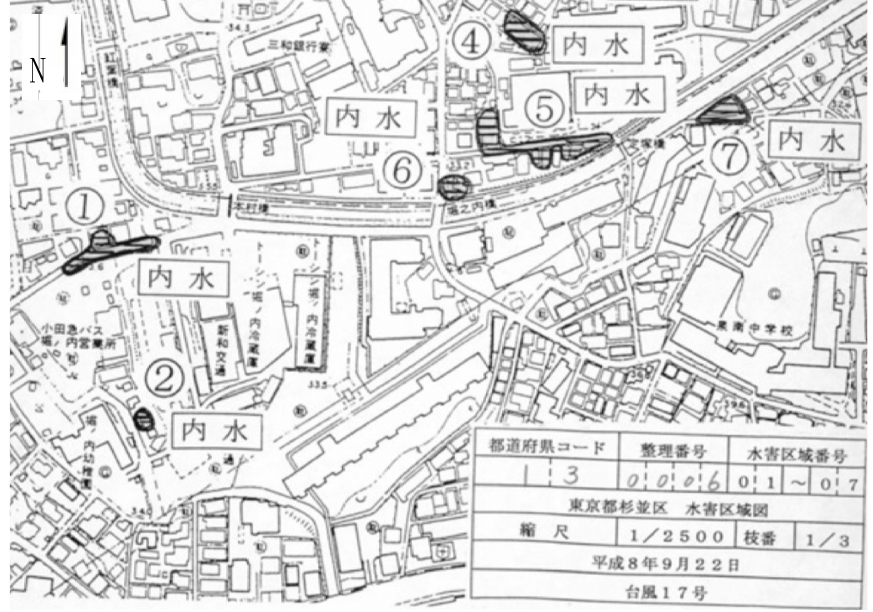
Figure 2. An example urban pluvial flooding area record (in Japanese). The seven shaded areas indicate the area where urban pluvial flooding occurred by Typhoon No. 17 on 22 September 1996. The scale of the map is